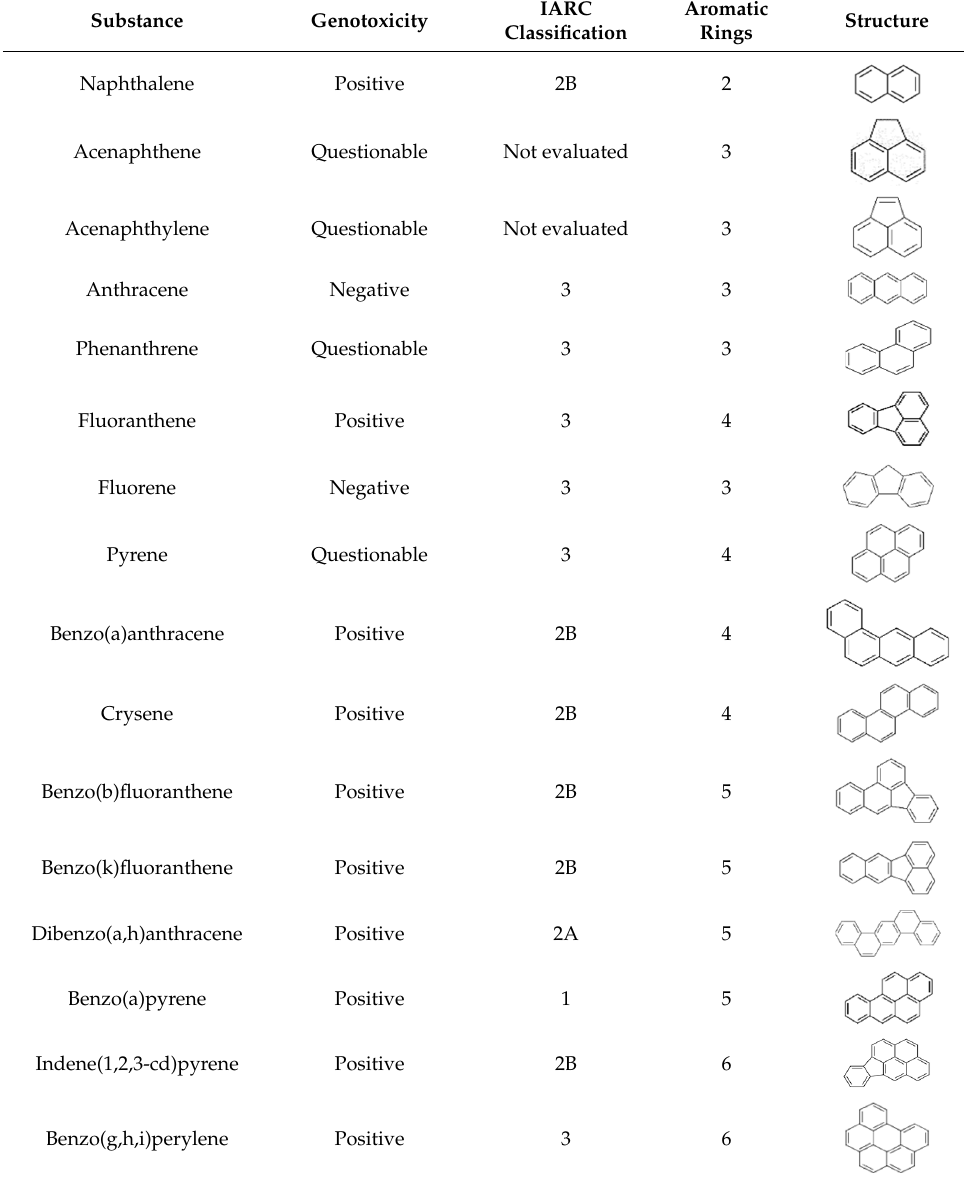
Table 1. Polycyclic aromatic hydrocarbons (PAHs) considered as a priority by the US Environmental Protection Agency and their IARC classification.